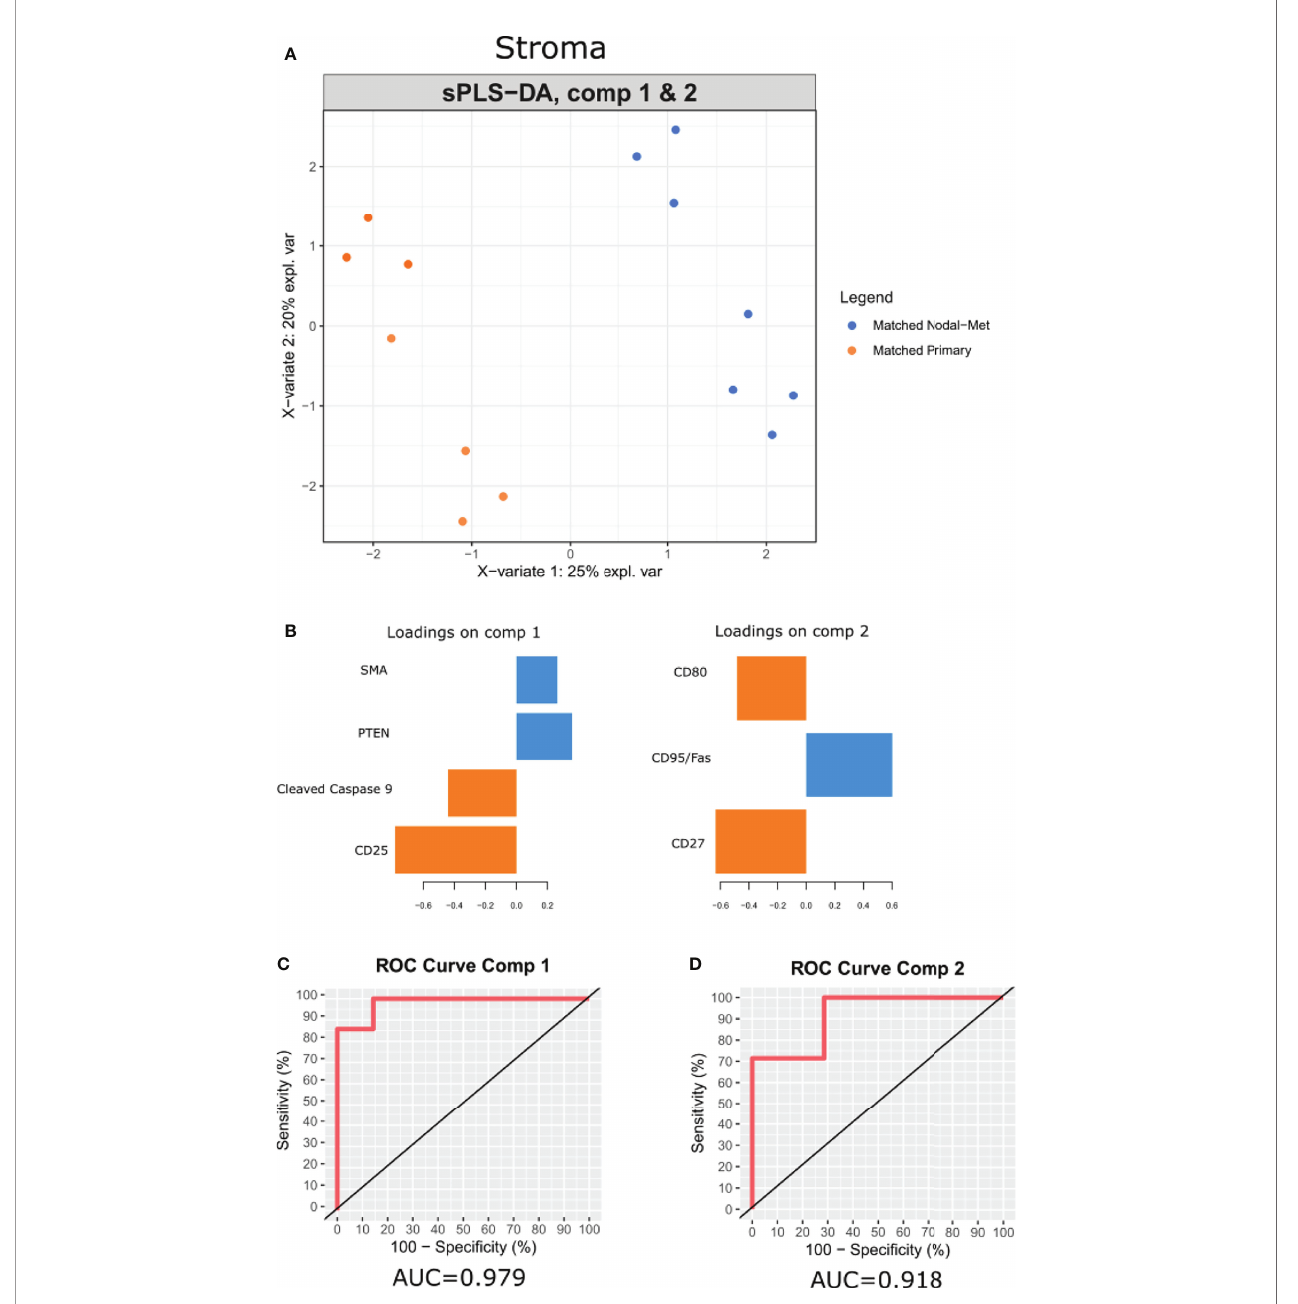
FIGURE 5 | A multi-protein signature differentiates OPSCC tumor progression. (A) sPLSDA distinguishes the groups (Matched Primary vs Matched Nodal Mets) by protein signatures in stroma. (B) Features of discriminating proteins per component in stroma. (C, D) ROC curve of each signature was used to differentiate the groups (Matched Primary vs Matched Nodal Mets). Color of component loadings indicates patient group in which feature was maximally expressed. Positive or negative values in bar chart indicate positive or negative loading to the discriminant